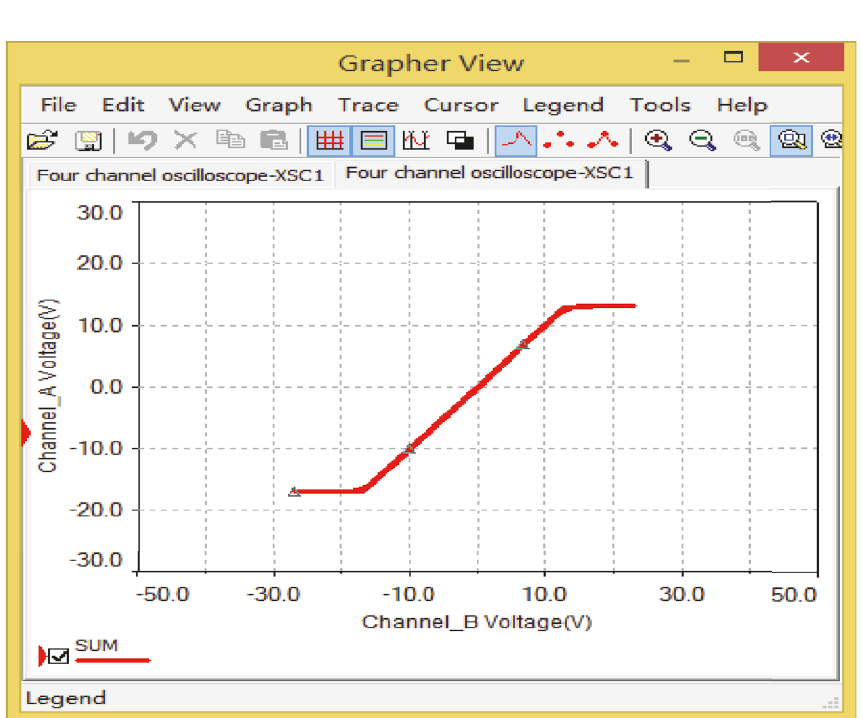
Figure 22: Synchronous phase portrait of 25